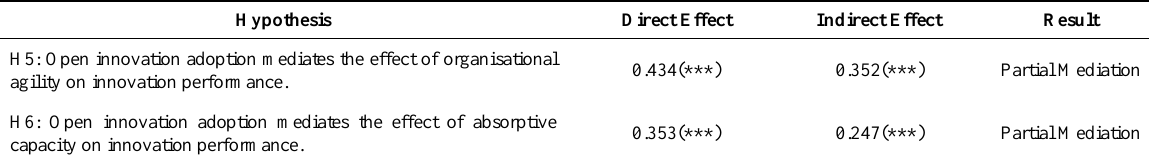
Table 6. The mediation analysis